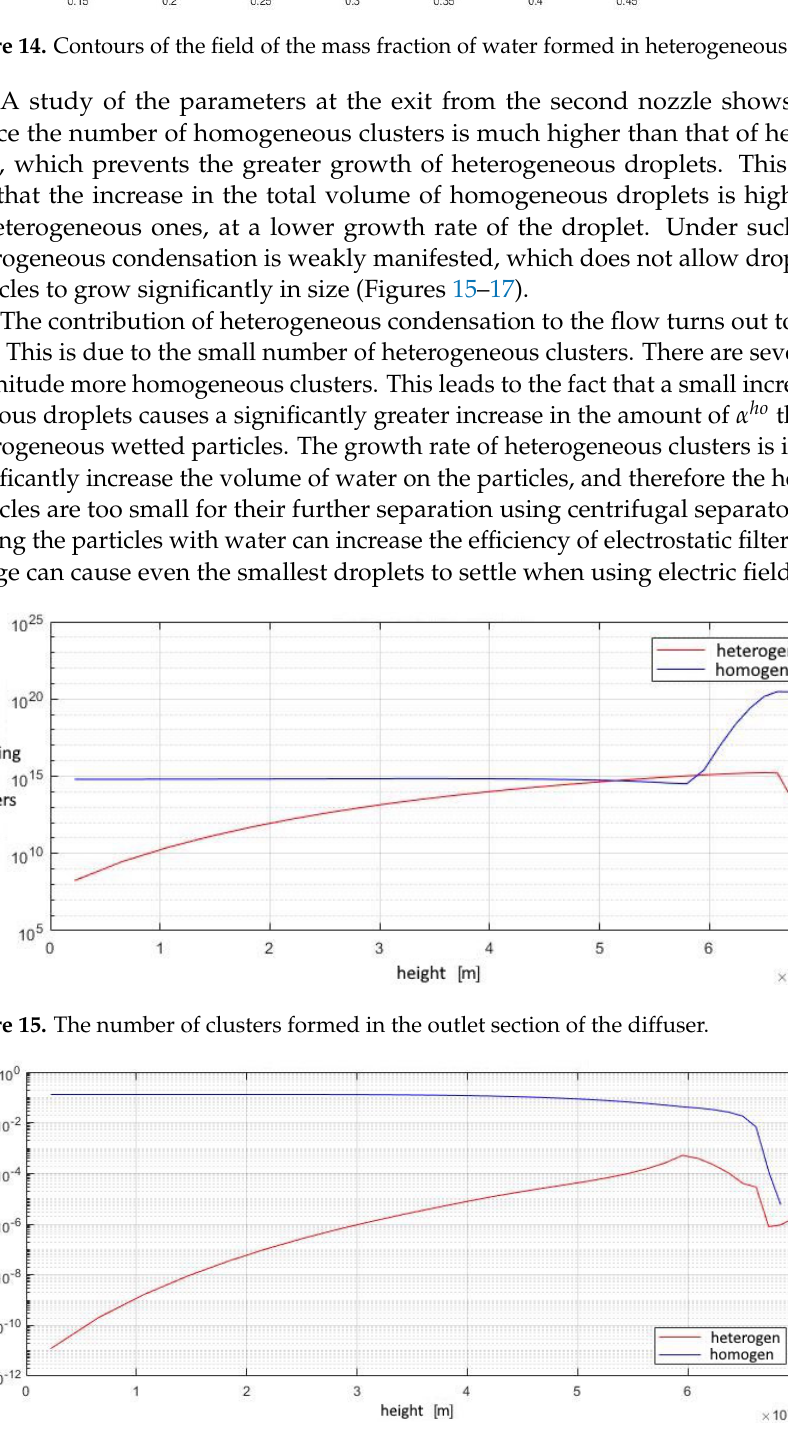
Figure 14. Contours of the field of the mass fraction of water formed in heterogeneous condensation.